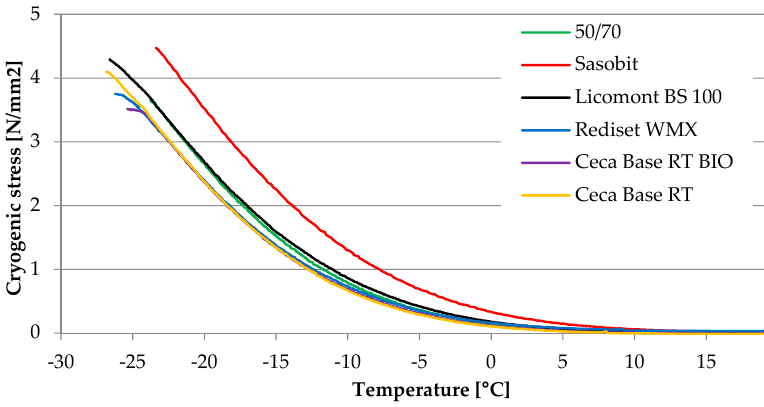
Figure 8. Graphical explanation of data assessment from the SCB test.